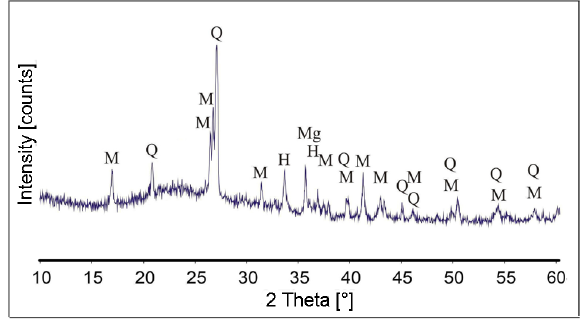
Fig. 1. XRD pattern of FA used (Q – quartz, M – mullite, Mg – magnetite, H – hematite)